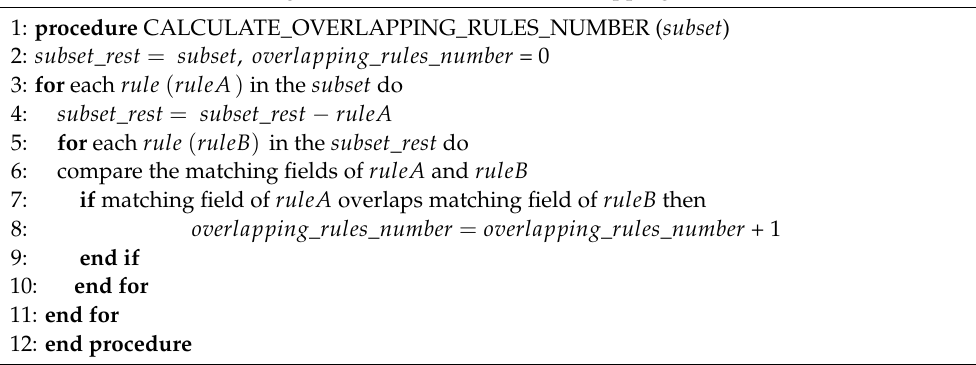
Algorithm 1. Calculation algorithm for the number of overlapping